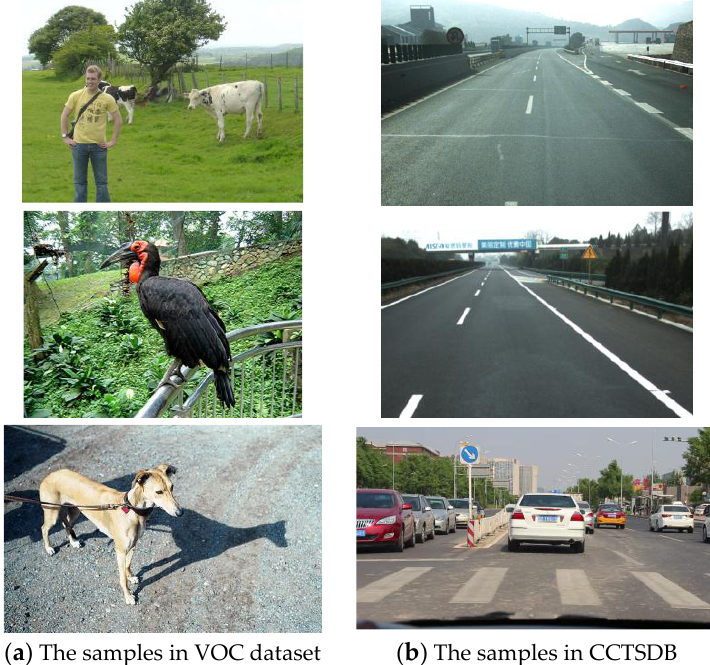
Figure 5. Some samples in the VOC and CCTSDB.